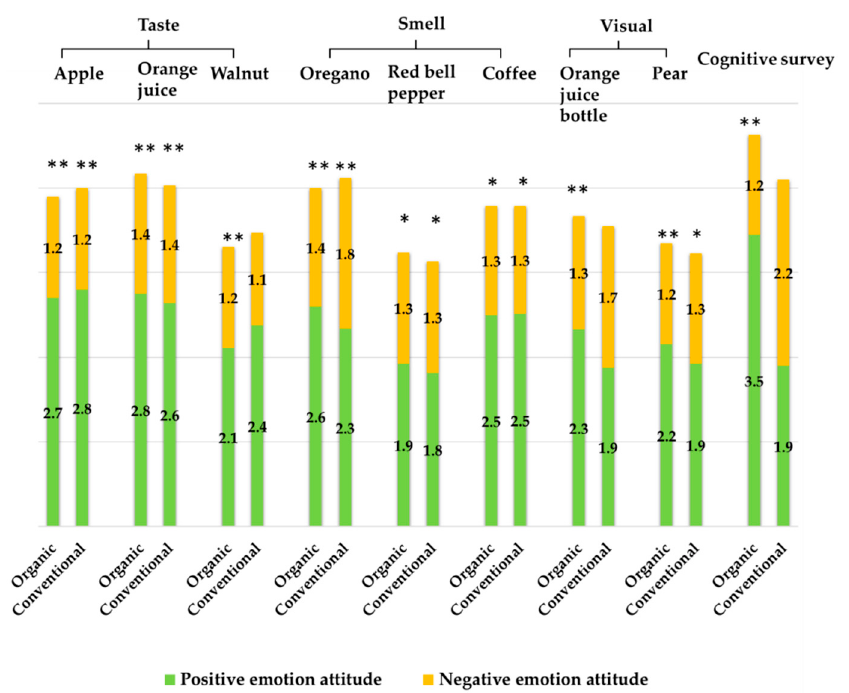
Figure 2. Emotion attitudes: food-elicited emotions expressed in the emotional profiling for each sample, and food-declared emotions declared in the cognitive survey. The data represents the rating values using the verbal emotion questionnaire of a 5-point scale: 1 = I do not feel it at all, 5 = I strongly feel it. (*) Significant differences between positive emotions and negative emotions: * p < 0.05, ** p < 0.01.